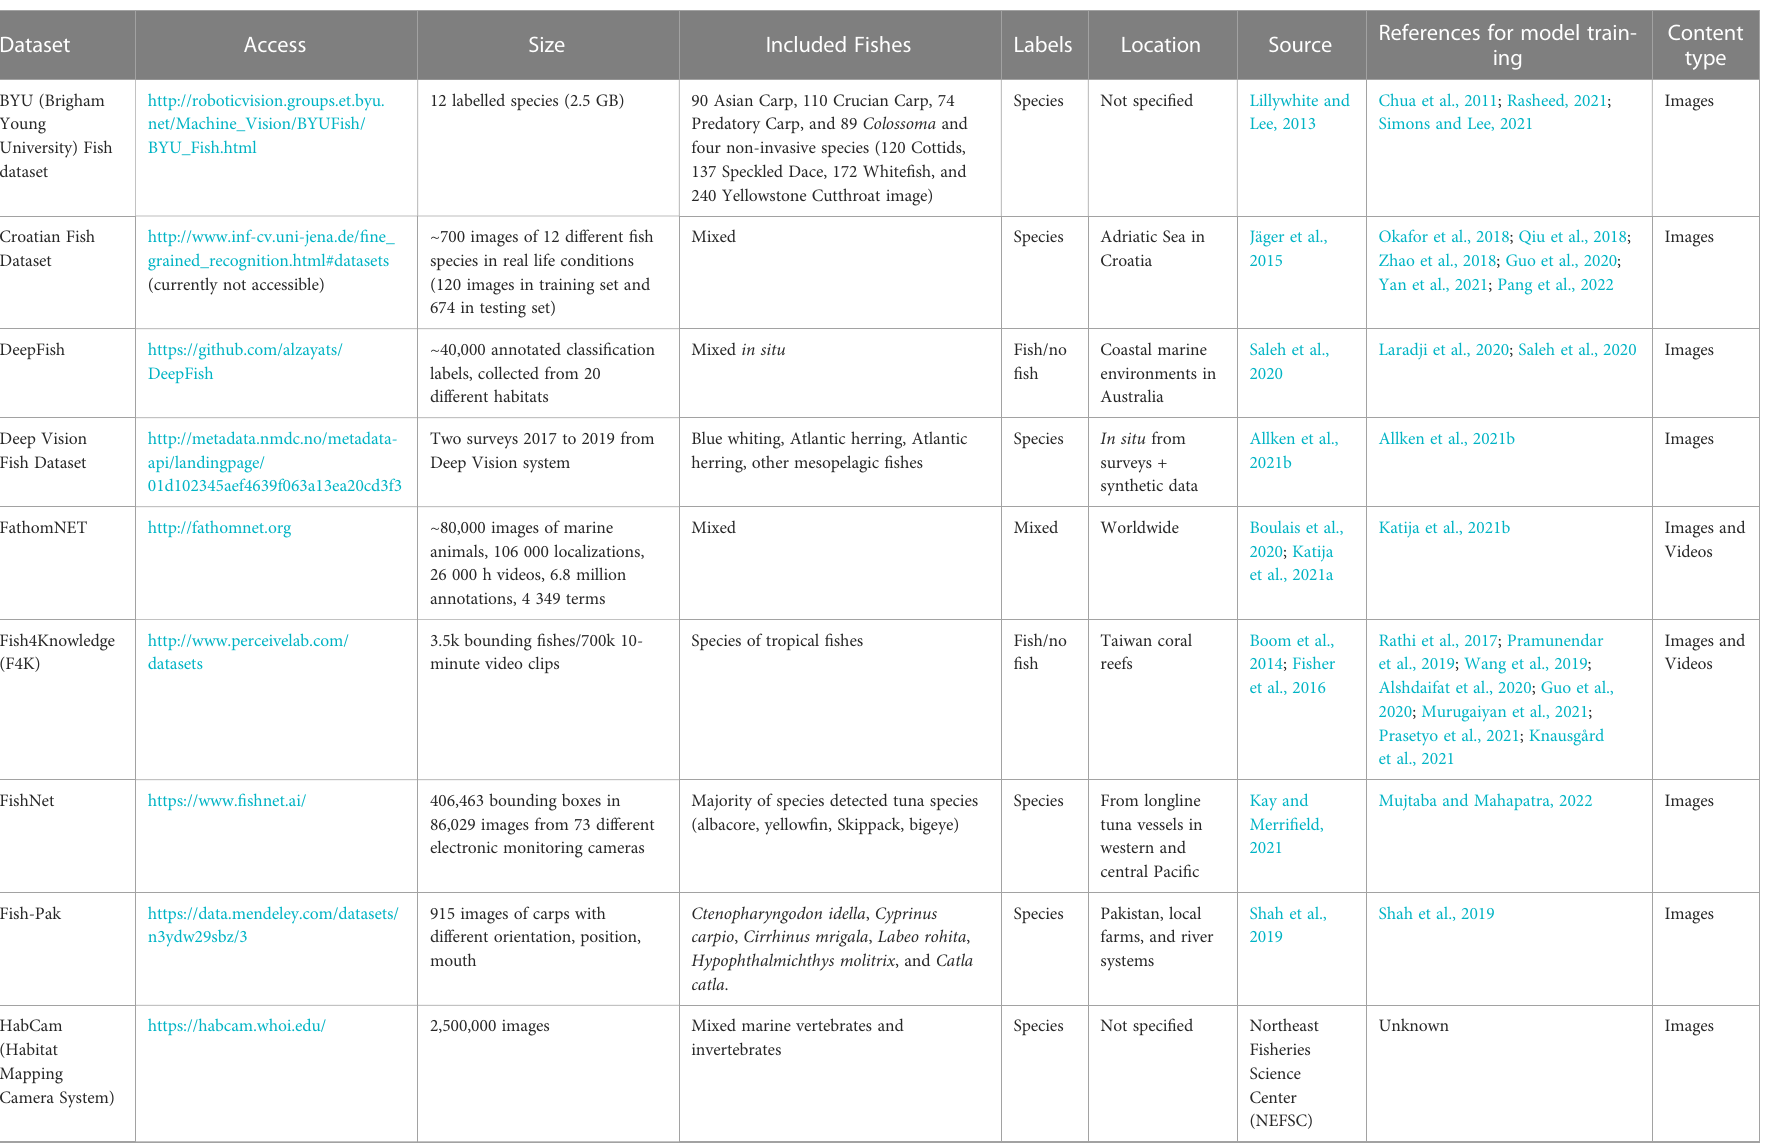
TABLE 4 Summary of public datasets of fi sh images and videos for AI model training merged from open access database, from collection of generic image datasets (with other objects not focused on fi shes) and from Ditria et al. (2020); Saleh et al. (2020) and Pedersen et al.